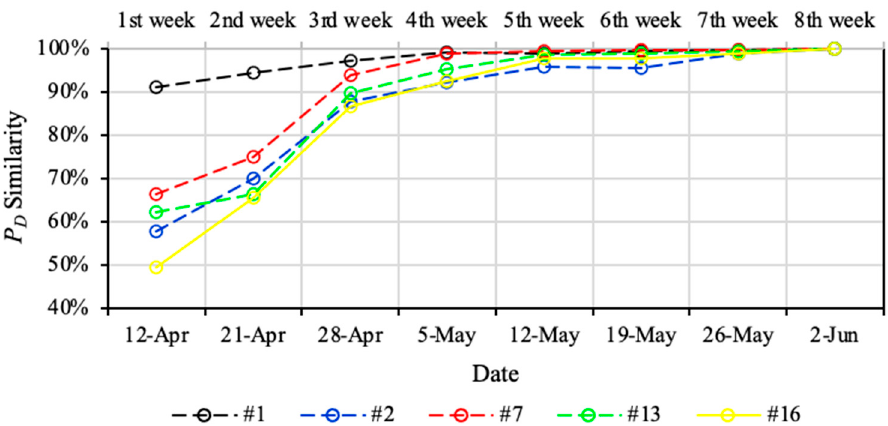
Figure 5. Similarity variation of geophones in LW250105 from 12 April to 2 June 2014. The similarity results of each geophone are calculated by comparing the final P D results on 2 June 2014.